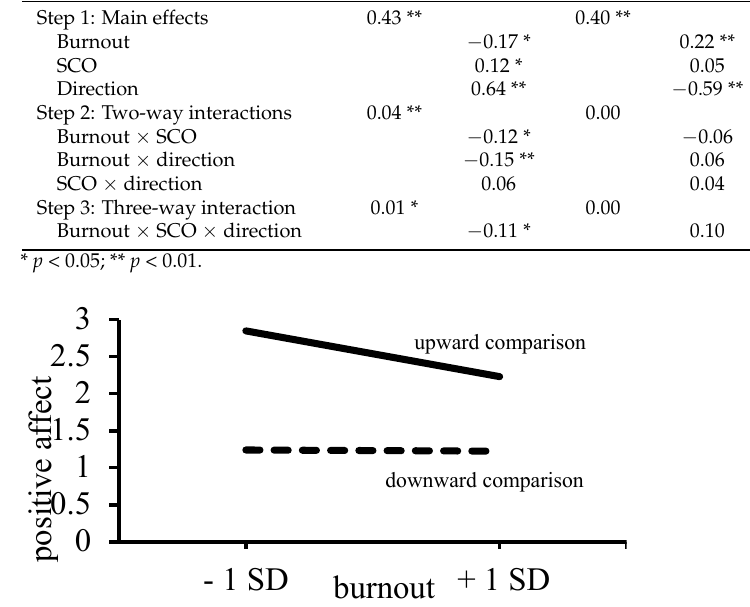
Figure 3. Positive affect as a function of burnout and comparison direction [13]. Individuals experienced less positive affect with increasing levels of burnout only after being confronted with an upward comparison target (upward, B = − 0.29, p < 0.01 vs. downward, B = − 0.01, ns ). There was no interaction between the burnout and comparison direction on negative affect, showing that after both downward and upward comparison,